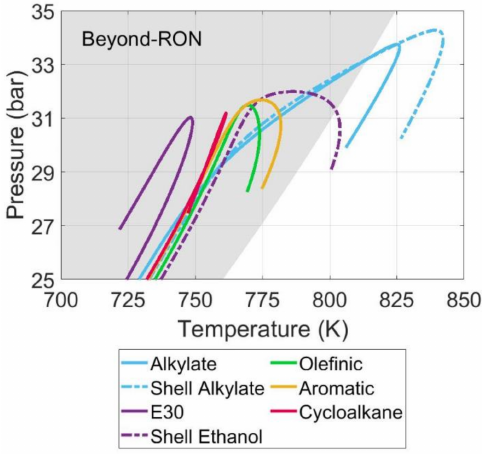
Figure 5. Detailed view of boosted SI PT trajectories showing PSHR tendencies of